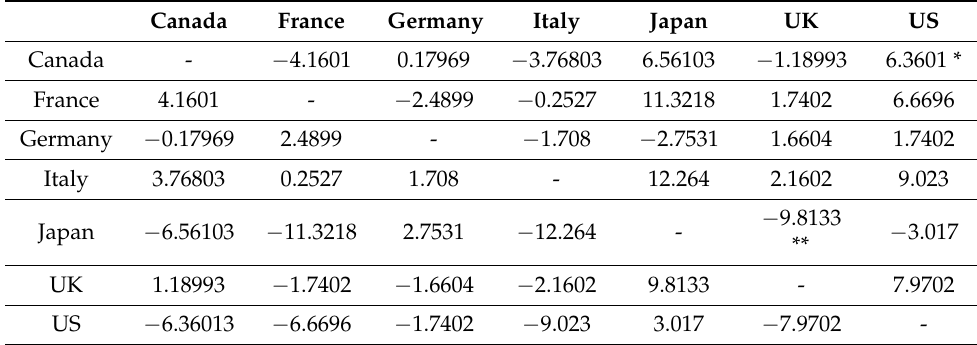
Table 3. Net pairwise inflation spillover based on the Diebold and Yilmaz (2012) methodology.